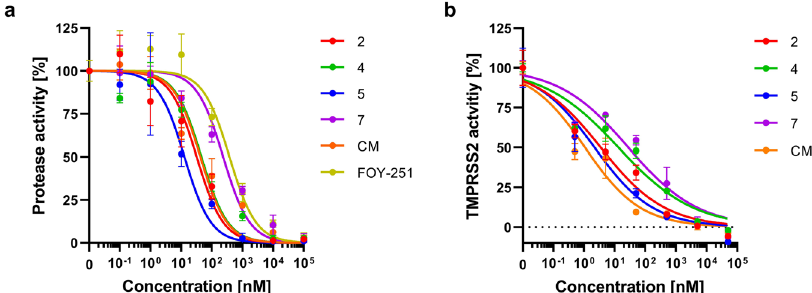
Fig. 4 Peptidomimetic inhibitors block cellular protease activity. a Peptidomimetic compounds 2, 4, 5, and 7 as well as camostat mesylate (CM) and FOY-251 were added to Caco-2 cells. After 30 min, the fl uorogenic reference substrate Boc-Gln-Ala-Arg-AMC was added, and the reaction rate of substrate degradation was assessed by recording the fl uorescence intensity within 2 h. b Peptidomimetic compounds 2, 4, 5, and 7 as well as camostat mesylate (CM) were added to HEK293T cells transiently expressing TMPRSS2, followed by addition of fl uorogenic reference substrate Boc-Gln-Ala-Arg- AMC. Graph shows normalized fl uorescence intensities after 2 h, corrected for the signal of mock-transfected HEK293T cells. Shown are the means ± SD of n = 1 experiment performed in triplicates ( a ) or duplicates ( b ). Calculated IC 50 values for each compound are presented in Supplementary Table